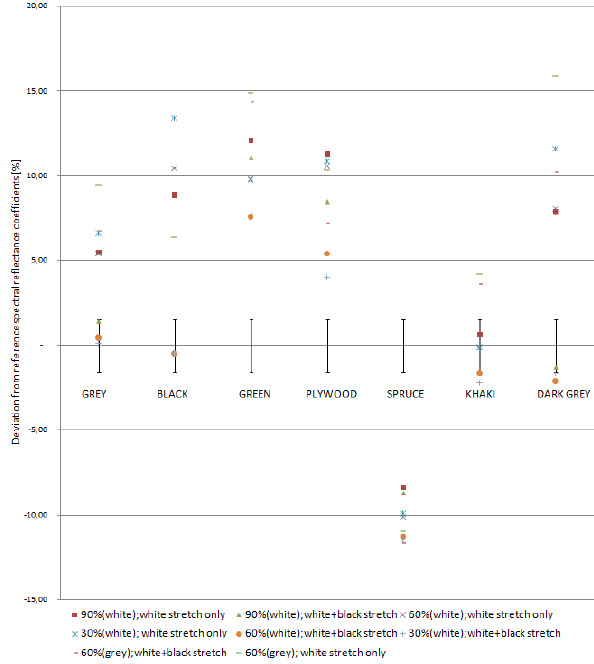
Figure 5. Deviation of spectral reflectance coefficients acquired using different methods in comparison to reference